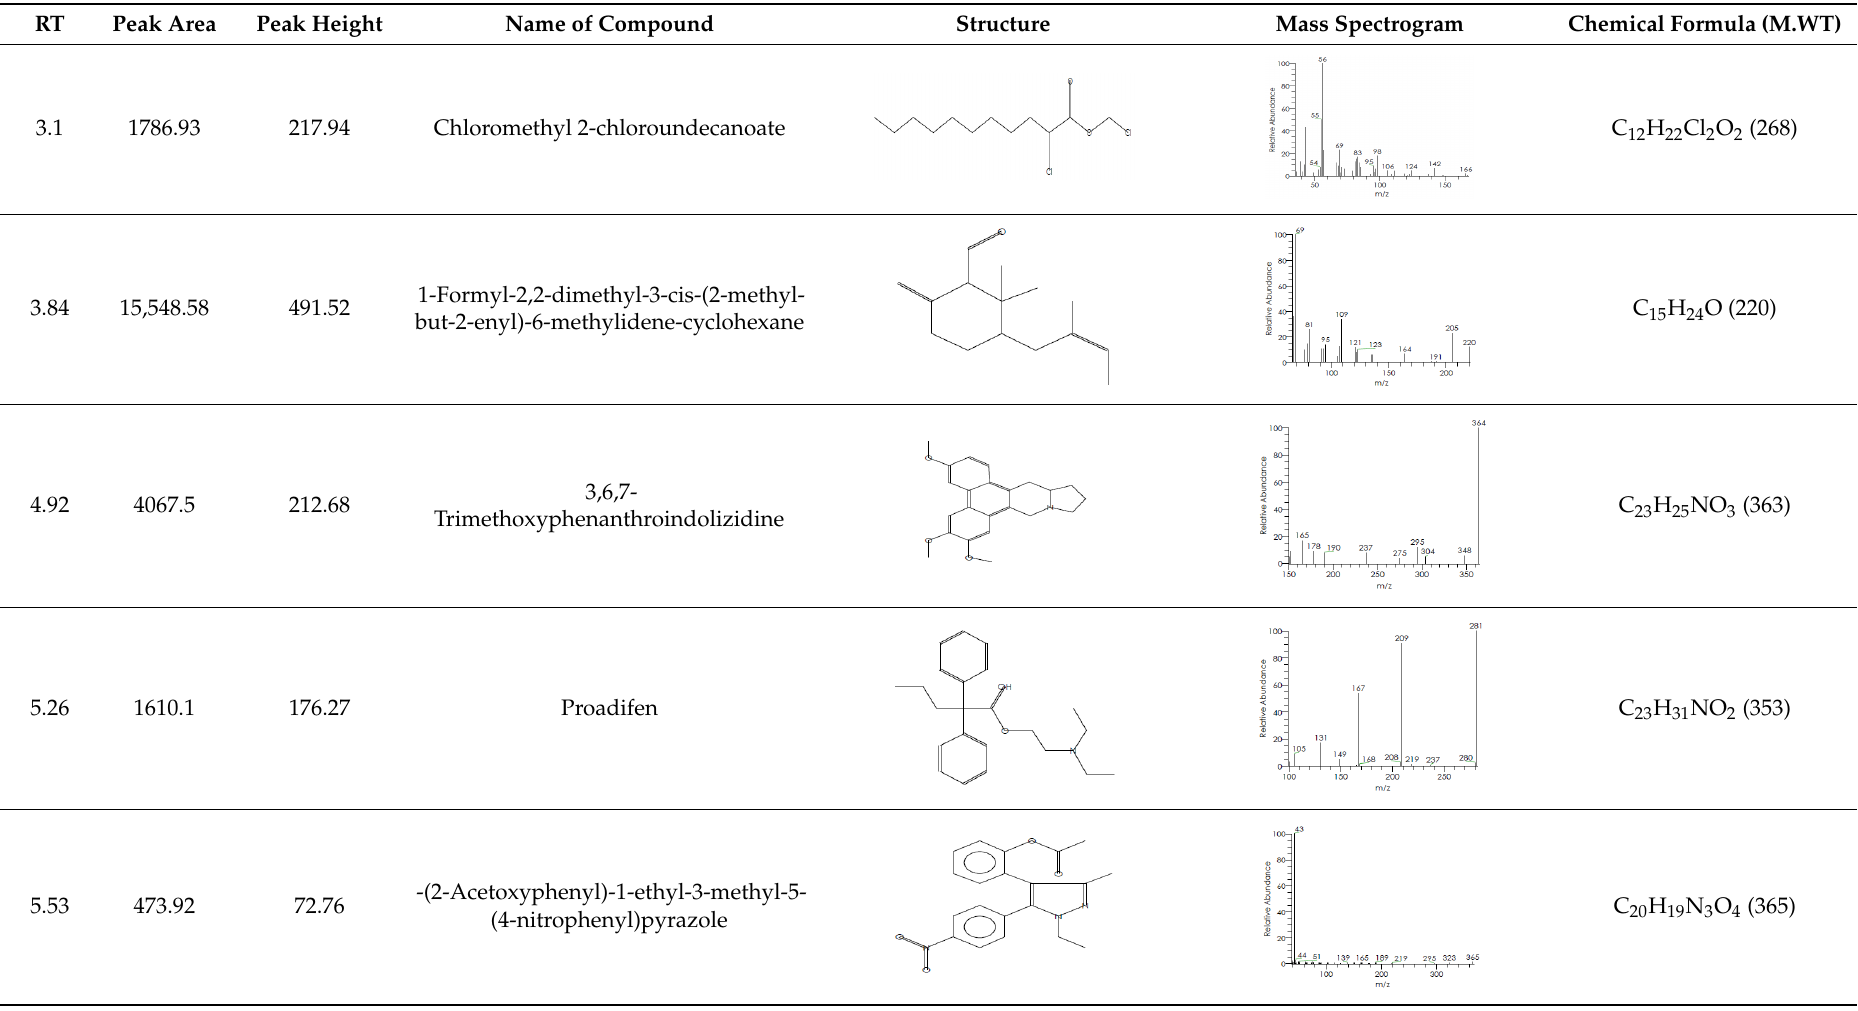
Chemical Formula